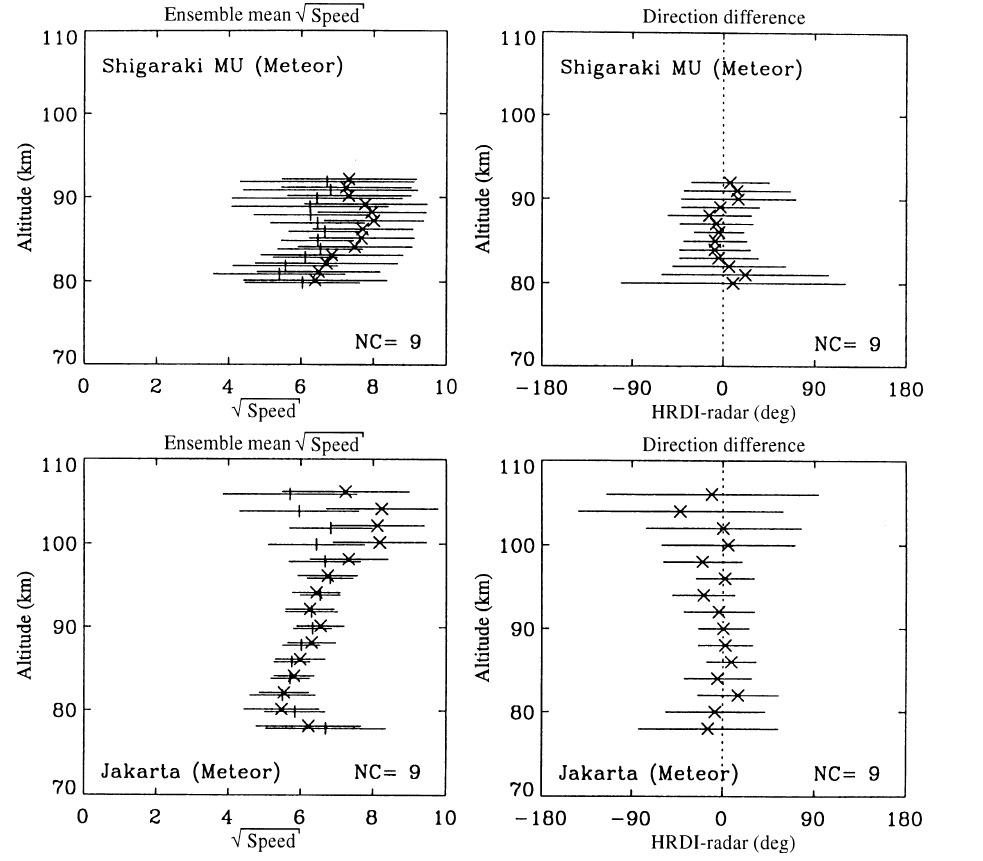
Fig. 8. Vertical profiles of left : the ensemble mean wind speed (taken by the square root) si- multaneously observed by HRDI ( crosses ) and radars ( pluses ), and right : the ensemble mean wind direction di(cid:128)erence. Horizontal bars are the confi- dence interval of 99% . To avoid overlap of bars, wind speeds are shifted 0.15 km up- ward for HRDI and 0.15 km downward